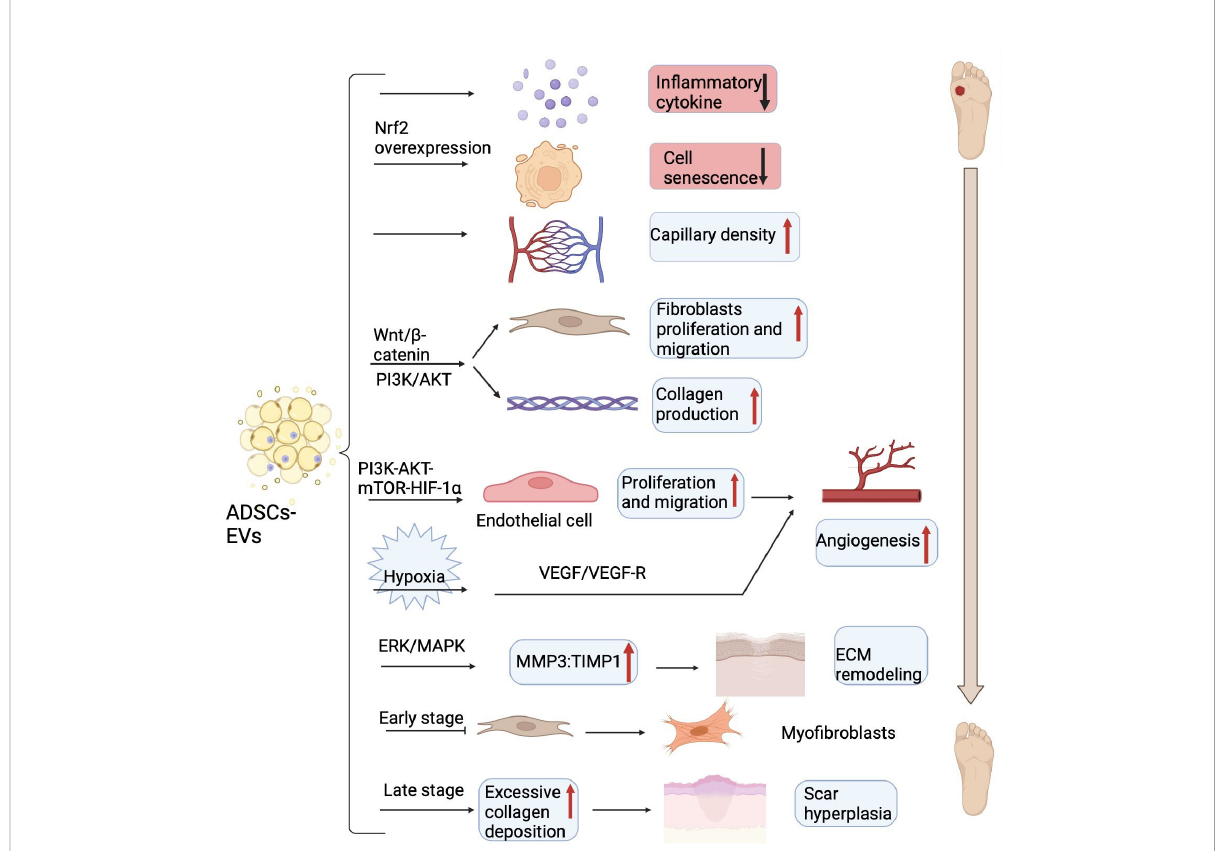
FIGURE 3 The main mechanism of ADSCs-EVs on DFU in experimental models. ADSCs-EVs can reduce in fl ammatory cytokines, prevent cell senescence, increase capillary density, promote fi broblasts proliferation and collagen secretion via Wnt/ b -catenin and PI3K/AKT signaling pathway to accelerate wound closure. ADSCs-EVs also can enhance the endothelial cells proliferation, migration, and tube formation through the PI3K- AKT-mTOR-HIF-1 a axis to motivate angiogenesis. Under hypoxia conditions, ADSCs-EVs enhanced neovascularization partially through VEGF/ VEGF-R pathway. ADSCs-EVs elevate the ratio of MMP3 to TIMP1 to remodel the extracellular matrix (ECM) and prevent fi broblasts differentiate into myo fi broblasts in the early stage and cause excess collagen deposition in the late stage. ADSCs-EVs, adipose tissue-derived stem cells- derived extracellular vesicles; DFU, diabetic foot ulcer; PI3K, phosphatidylinositol-4,5-bisphosphate 3-kinase; AKT, protein kinase B; mTOR, mechanistic target of rapamycin; HIF-1 a , hypoxia-inducing factor alpha; VEGF, vascular endothelial growth factor; VEGF-R, vascular endothelial growth factor receptor; MMP3, matrix metalloproteinase 3; TIMP1, tissue inhibitor of matrix metalloproteinases-1; ECM, extracellular matrix. Figure created using BioRender